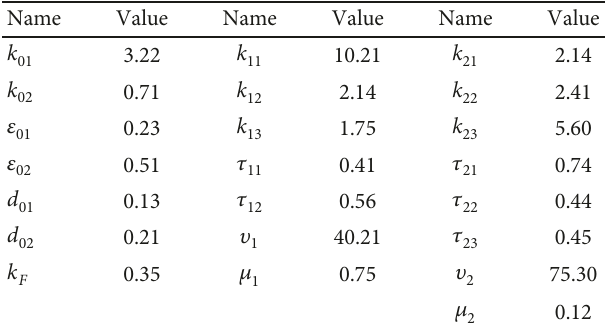
Table 4: Parameter optimization value of the IGC method for the invariable span missile.